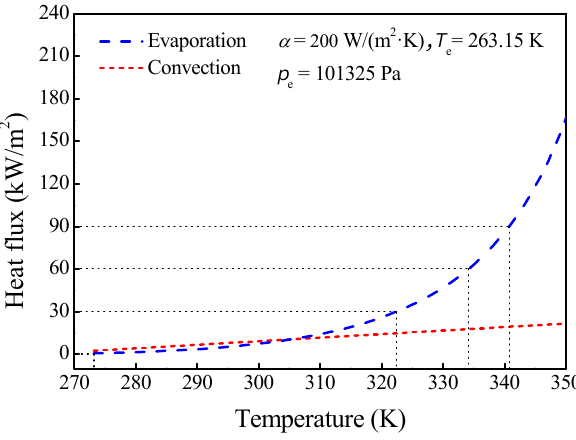
Figure 16. Changes of q evap and q conv with the surface temperature.